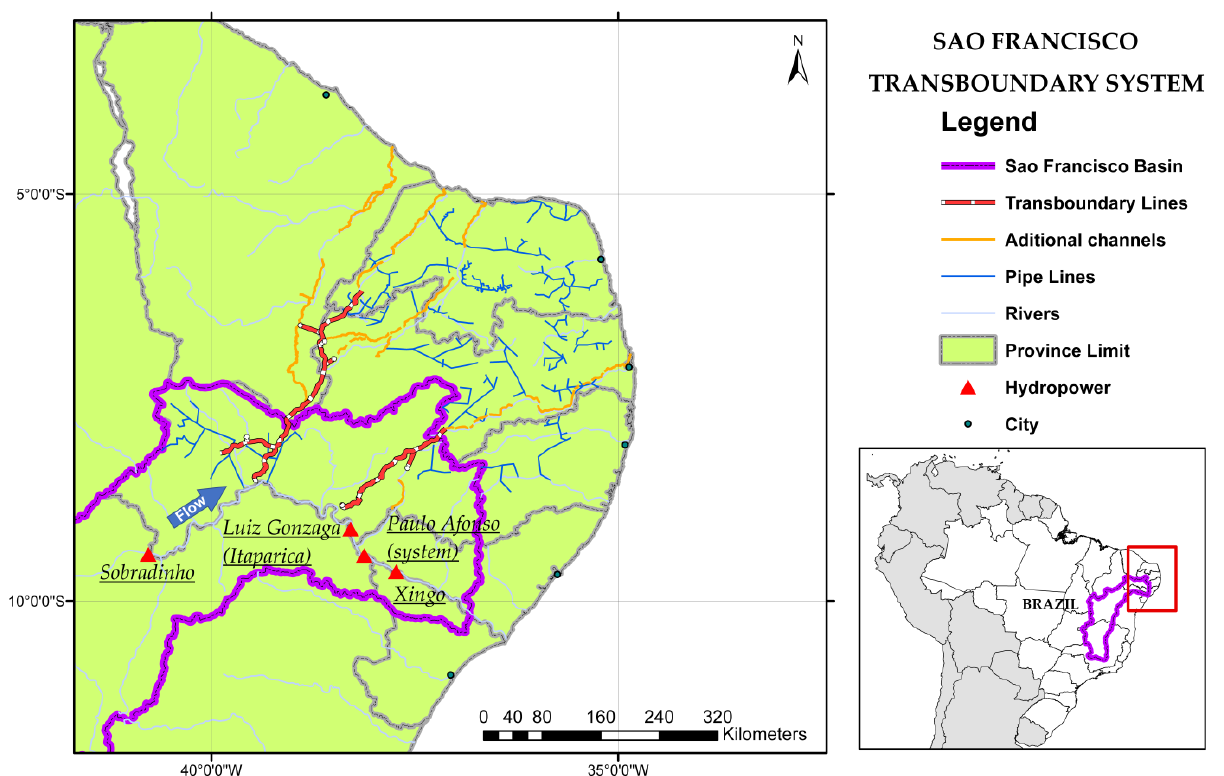
Figure 5. The São Francisco basin and its transboundary